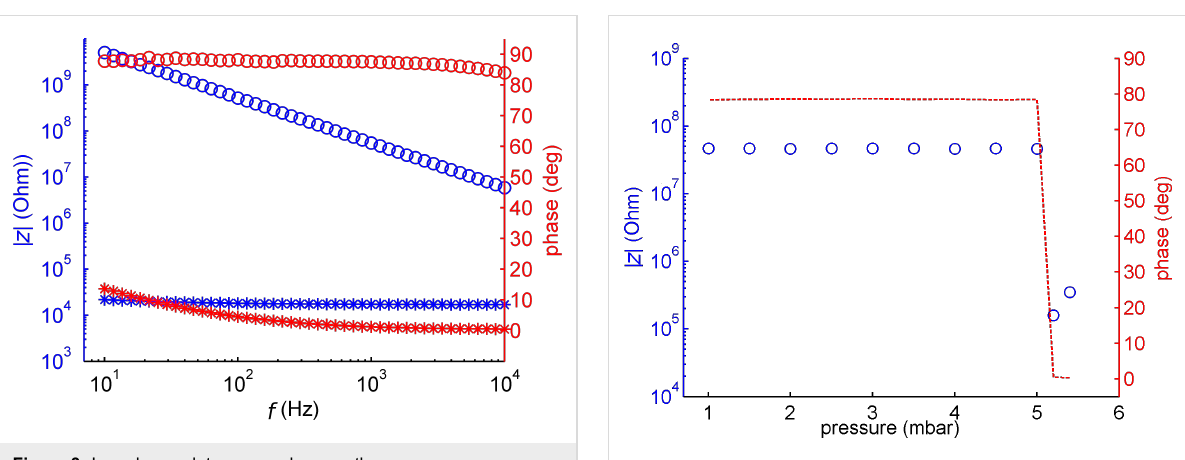
of 300 µm 2 in which the pores penetrate the whole substrate.